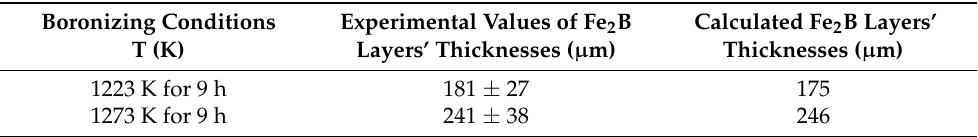
Figure 17. SEM images of the cross-sectional views of boride layers corresponding to two boriding temperatures for 9 h of treatment: ( a ) 1223 K and ( b ) 1273 K. Table 3. Experimental data for layer thicknesses produced at 1223 and 1273 K during 9 h compared with the calculated values from Equation (6) for a C Fe 2 B up = 9 wt